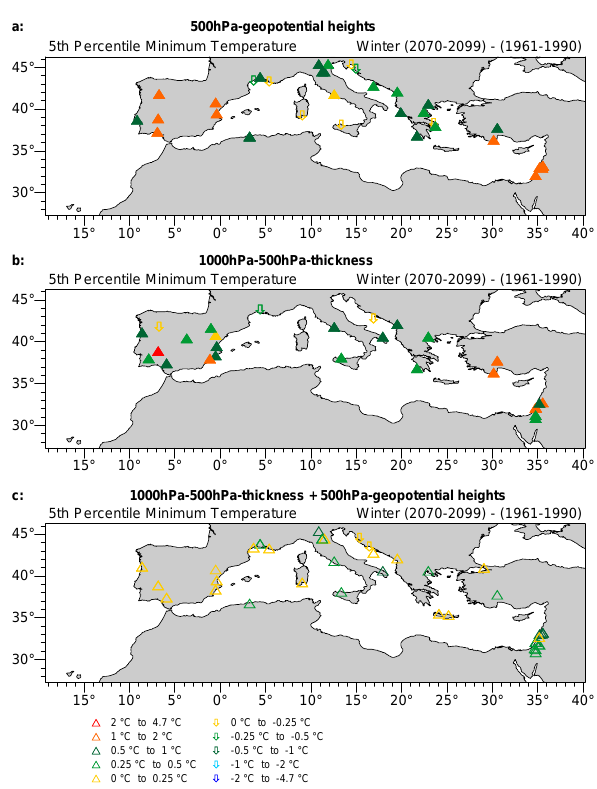
Figure 9: Changes of the 5 th percentile of minimum temperatures in winter (December to February) according to statistical downscaling assessments using ECHAM5/MPI-OM Fig. 9. Changes of the 5th percentile of minimum temperatures predictors under SRES A1B scenario assumptions. Differences of the seasonal extreme in winter (December to February) according to statistical down- indices between the periods 2070-2099 and 1961-1990 in °C. Statistical downscaling technique: Multiple Regression analysis. Colour-filled symbols: signal/noise ratio greater than scaling assessments using ECHAM5/MPI-OM predictors under 1. Figure 9a: Predictor: 500hPa-geopotential heights, Fig. 9b: Predictor: 1000hPa-500hPa- SRES A1B scenario assumptions. Differences of the seasonal ex- thickness. Fig. 9c: Predictors: 1000hPa-500hPa-thickness and 500hPa-geopotential heights. treme indices between the periods 2070–2099 and 1961–1990 in ◦ C. Statistical downscaling technique: Multiple Regression analy- sis. Colour-filled symbols: signal/noise ratio greater than 1. (a) Predictor: 500hPa-geopotential heights, (b) Predictor: 1000hPa– 500hPa-thickness. (c) Predictors: 1000hPa–500hPa-thickness and 500hPa-geopotential